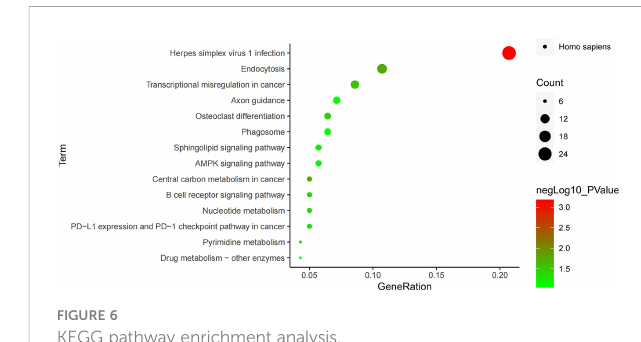
FIGURE 5 GO enrichment analysis.